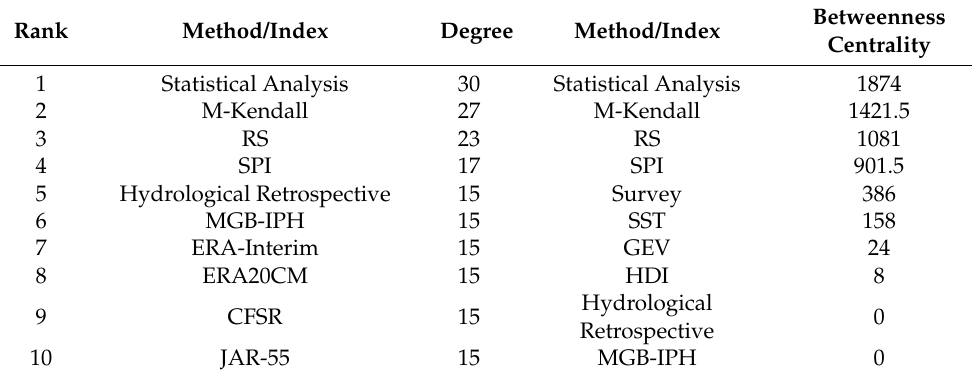
Table 3. List of the top ten most frequently used methods and indices in the network, with high degree (left) and high betweenness